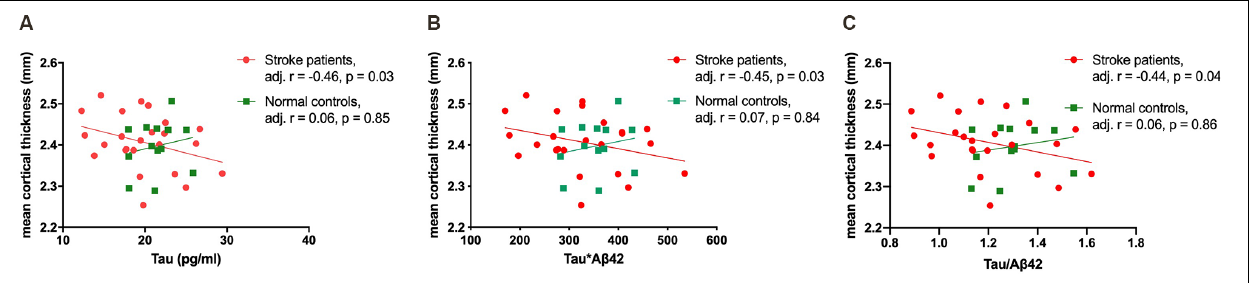
In all participants, plasma levels of A β 40, A β 42/A β 40, tau/A β 40, and tau ∗ A β 42/A β 40 were all significantly correlated with the GDS and DRS-2 total scores, respectively, and remained significant after controlling for age and education ( Table 3 ). ( Figure 2 ). The correlations of stroke volume with the NIHSS, MMSE, GDS and DRS-2 total scores were not significant.